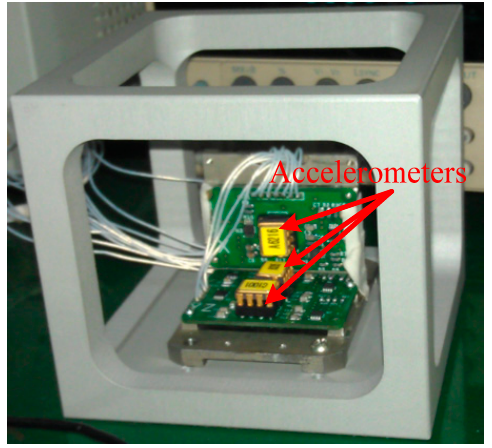
Figure 6. Mounted accelerometers in the test.